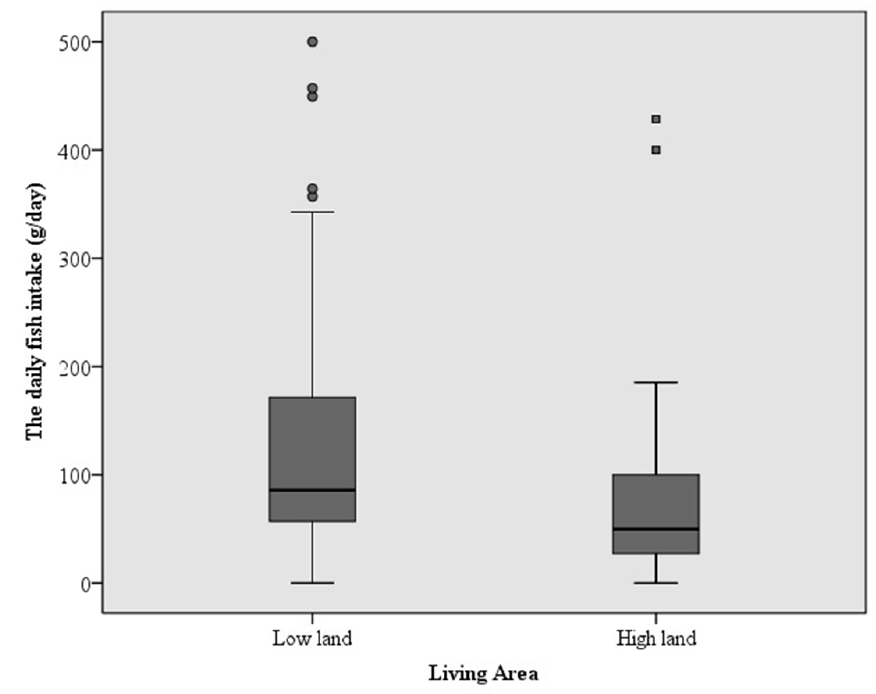
Figure 3. Comparison of daily fish consumption between subjects living in lowland and highland areas. The p -value was 0.002 by the Mann–Whitney U test.